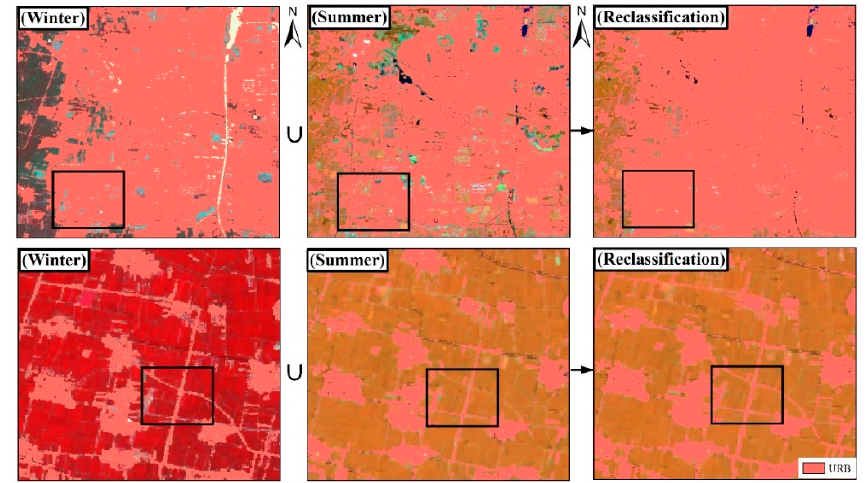
Figure 7. Reclassification results for urban and rural residents. ∪ is the union